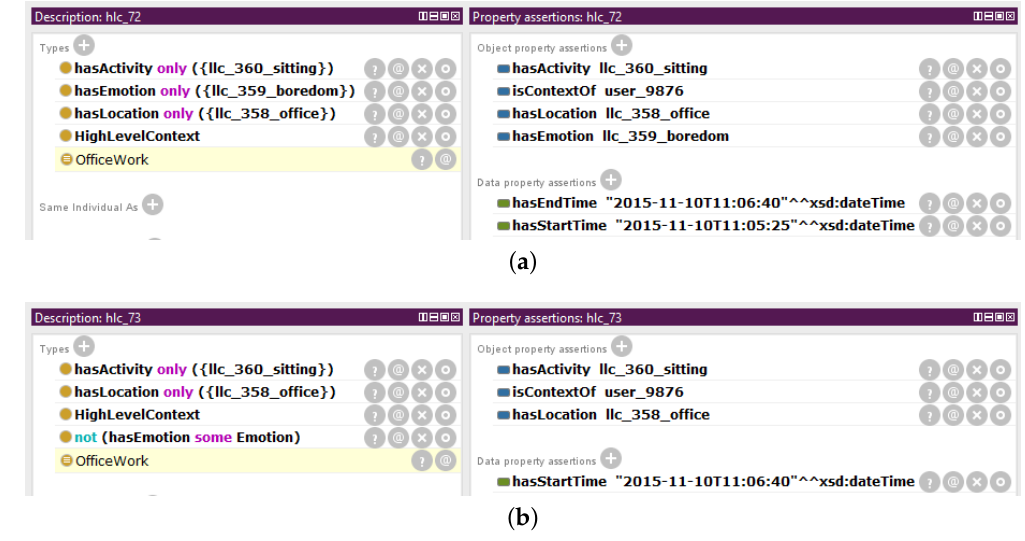
Figure 7. Representation of the instances of classified high-level context for the exemplary scenario by using the Mining Minds Context Ontology in Protégé. ( a ) hlc_72 ; and ( b ) hlc_73 , which are both inferred to be members of the class OfficeWork , are composed of some of the low-level contexts llc_358_office (member of the class Office ), llc_359_boredom (member of the class Boredom ) and llc_360_sitting (member of the class Sitting